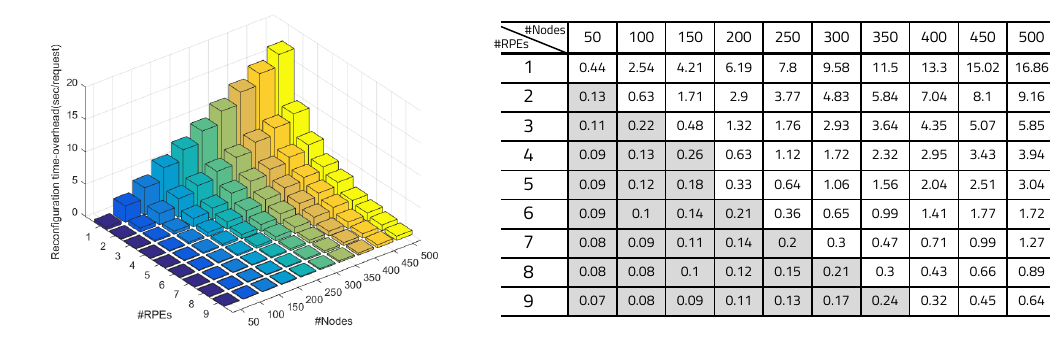
Figure 23. Reconfiguration overheads according to the number of reconfiguration engines and